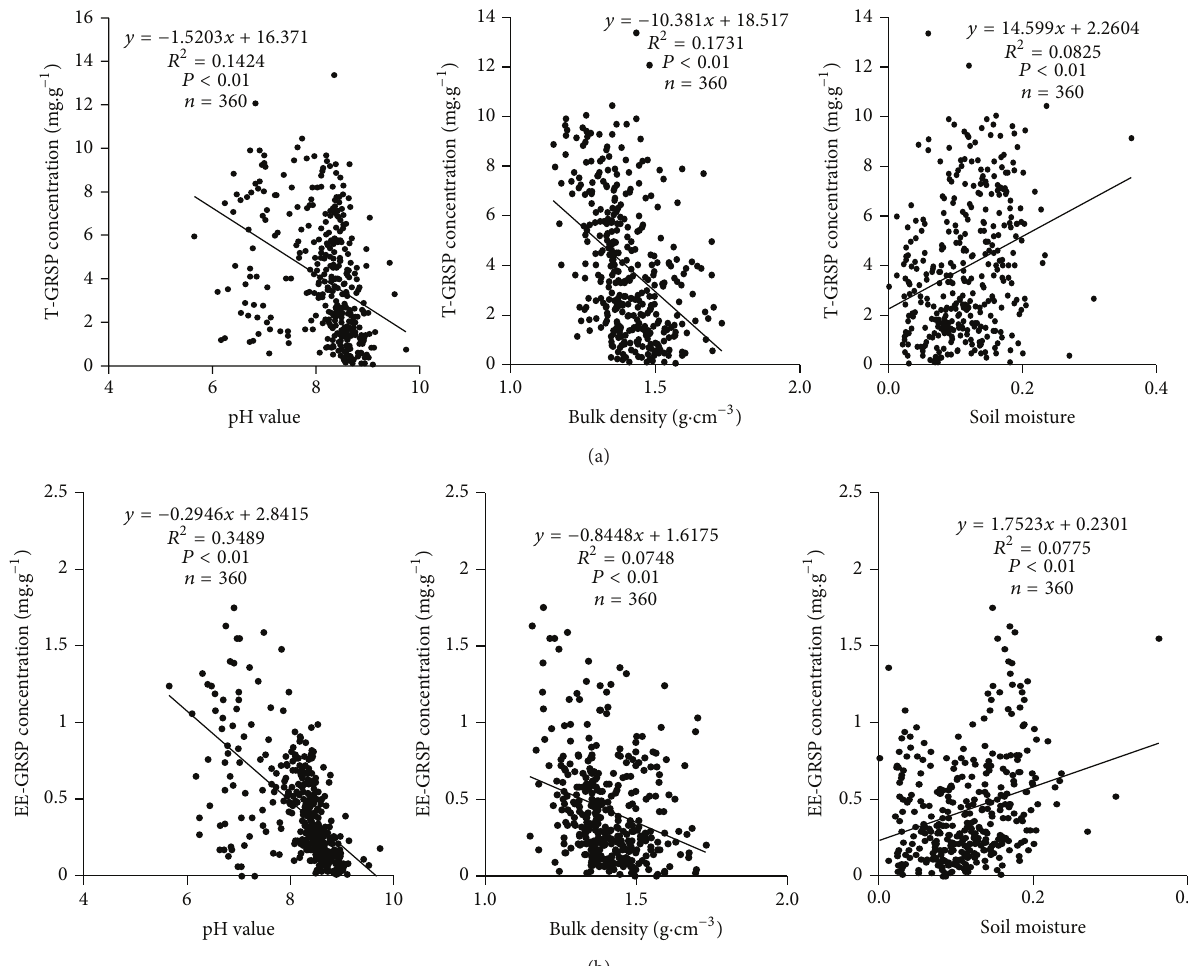
Figure 3: Correlations between soil pH, bulk density, moisture, and T-GRSP concentration (a) and between these parameters and EE-GRSP concentration